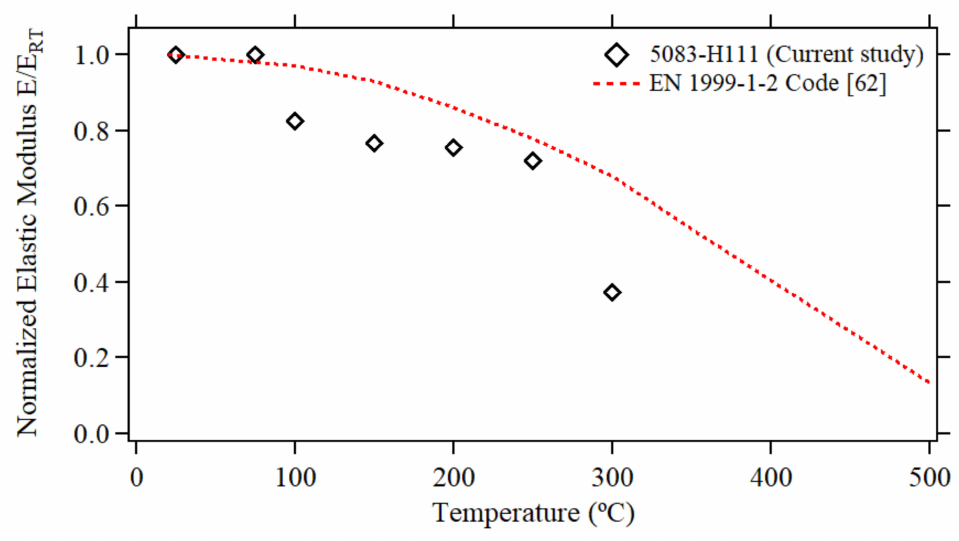
Figure 7. Normalized elastic modulus versus temperature (normalized by the RT elastic